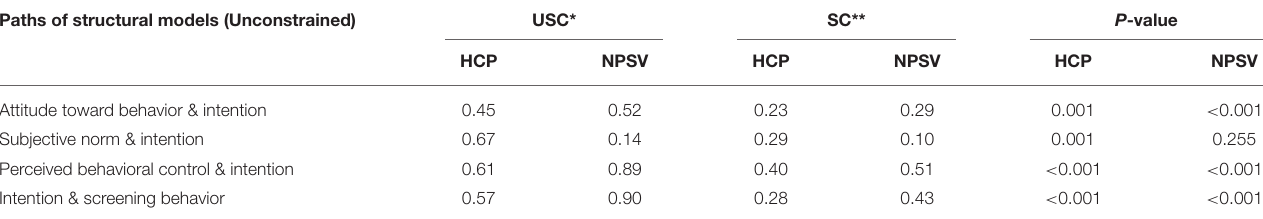
TABLE 3 | Path coefficients of the unconstrained multi-group